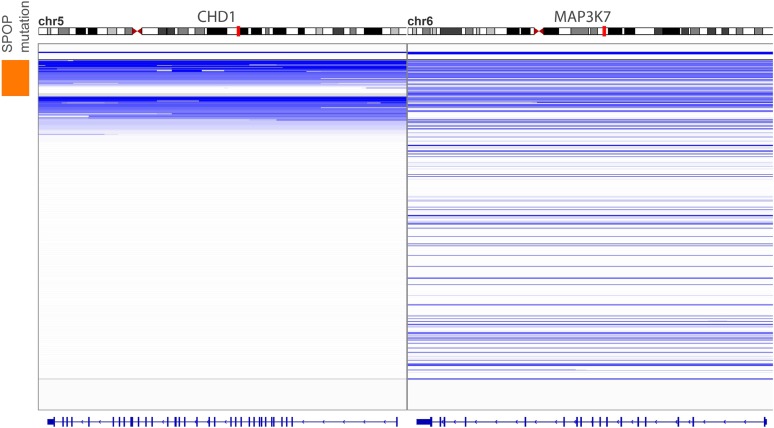
Genomic view of CHD1 and MAP3K7 areas in 430 prostate cancers sorted by SPOP mutation status.Blue indicates genomic deletion.